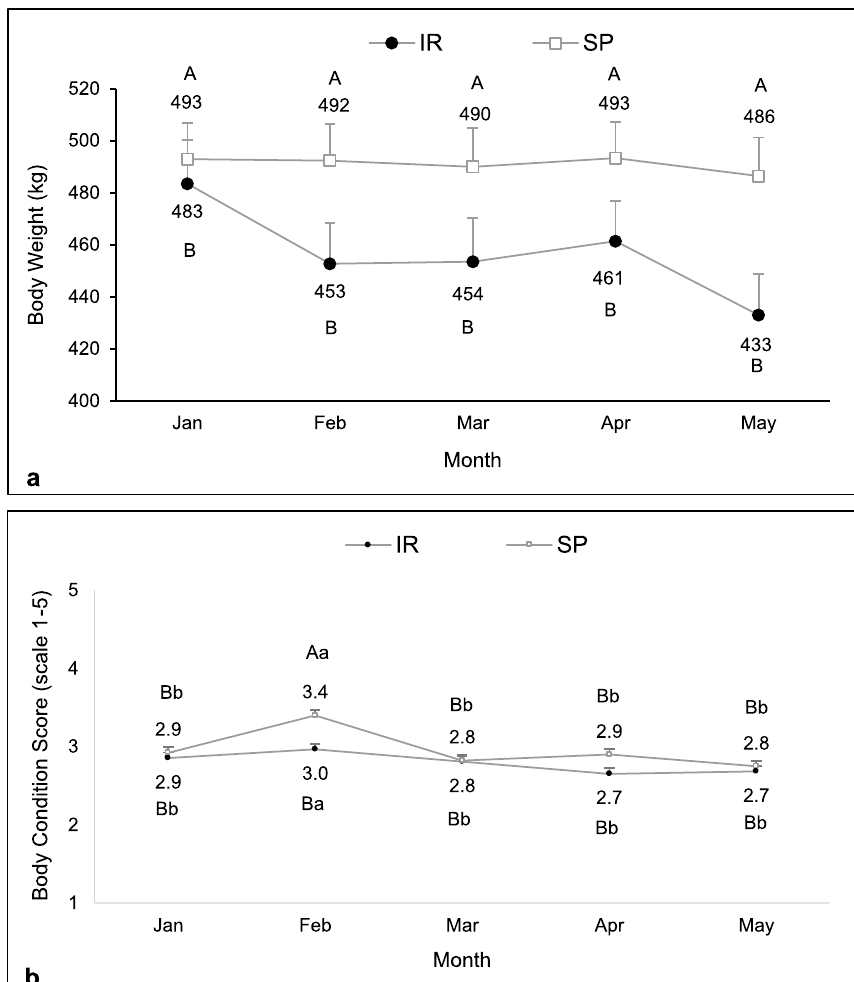
Figure 9. Body weight ( a ) and body condition score ( b ) of females kept in the silvopastoral (SP) or intensive rotational grazing (IR) systems from January to May 2017. Body weight was influenced by system, and body condition score by an interaction between system and month. A,B Different capital letters indicate a significant difference between systems. a,b,c Different lowercase letters indicate a significant difference between months.